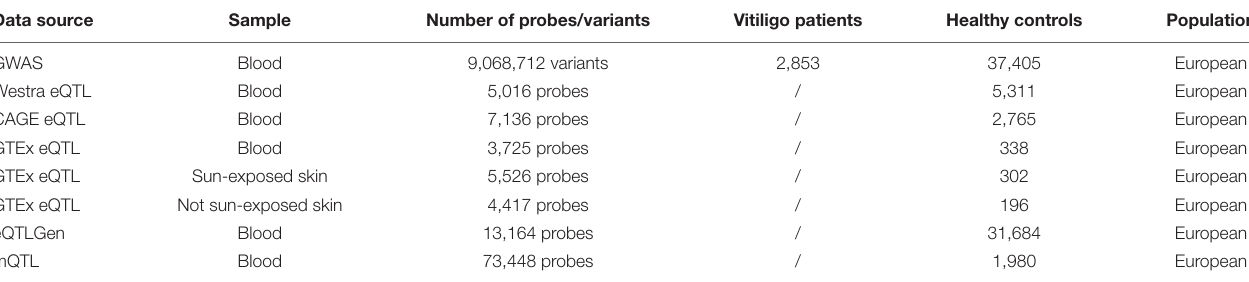
FIGURE 1 | The pipeline of our integrative analysis of vitiligo. Integrative analysis of mQTL, eQTL, and vitiligo GWAS data to prioritize DNAm sites, putative functional genes, shared causal variants, and reveal a possible regulatory mechanism that the effect of genetic variants on vitiligo susceptibility is mediated by altering gene expression through DNAm. TABLE 1 | Description of summary-level